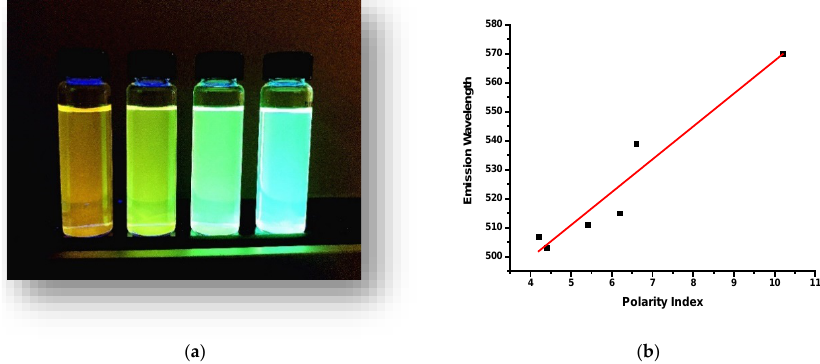
Figure 3. ( a ) Solvent effect of O-CDs (0.15 mg/mL). (Solvent from left to right: water, methanol, acetone and tetrahydrofuran). ( b ) X axis: the polarity index of different solvents (water, methanol, acetonitrile, acetone, chloroform, tetrahydrofuran); Y axis: the maximum emission wavelength of O-CDs; the linear relation between the two factors can be described as following equation: Y = 11.33X + 454.31, R 2 = 0.91.